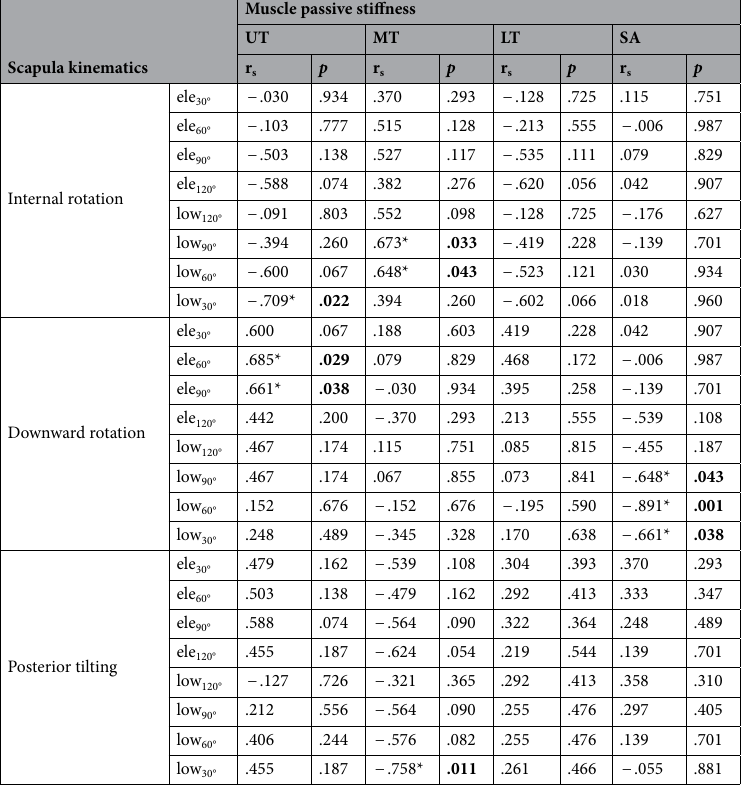
Table 1. The relationship between the passive stiffness of scapular muscles and the scapular kinematics. *Significant correlation between the muscle passive stiffness and the scapular kinematics ( p < 0.05). P values set in bold indicate statistical